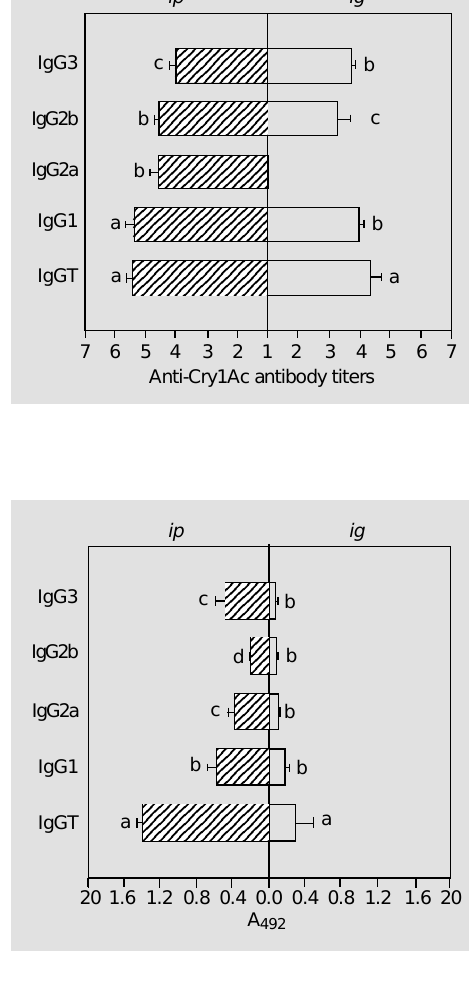
Figure 4 - Subclasses of anti- pCry1Ac IgG coproantibodies in the small intestinal fluids after ip or ig immunization with 100 µg of pCry1Ac. The mean A 492 values of nonimmunized mice were 0.073 ± 0.01. Bars repre- sent the level of antibodies re- ported as arbitrary units of A 492 ± SD for each experimental group (N = 5). The letters on top of the bars represent the differ- ences observed by the New- man-Keuls test